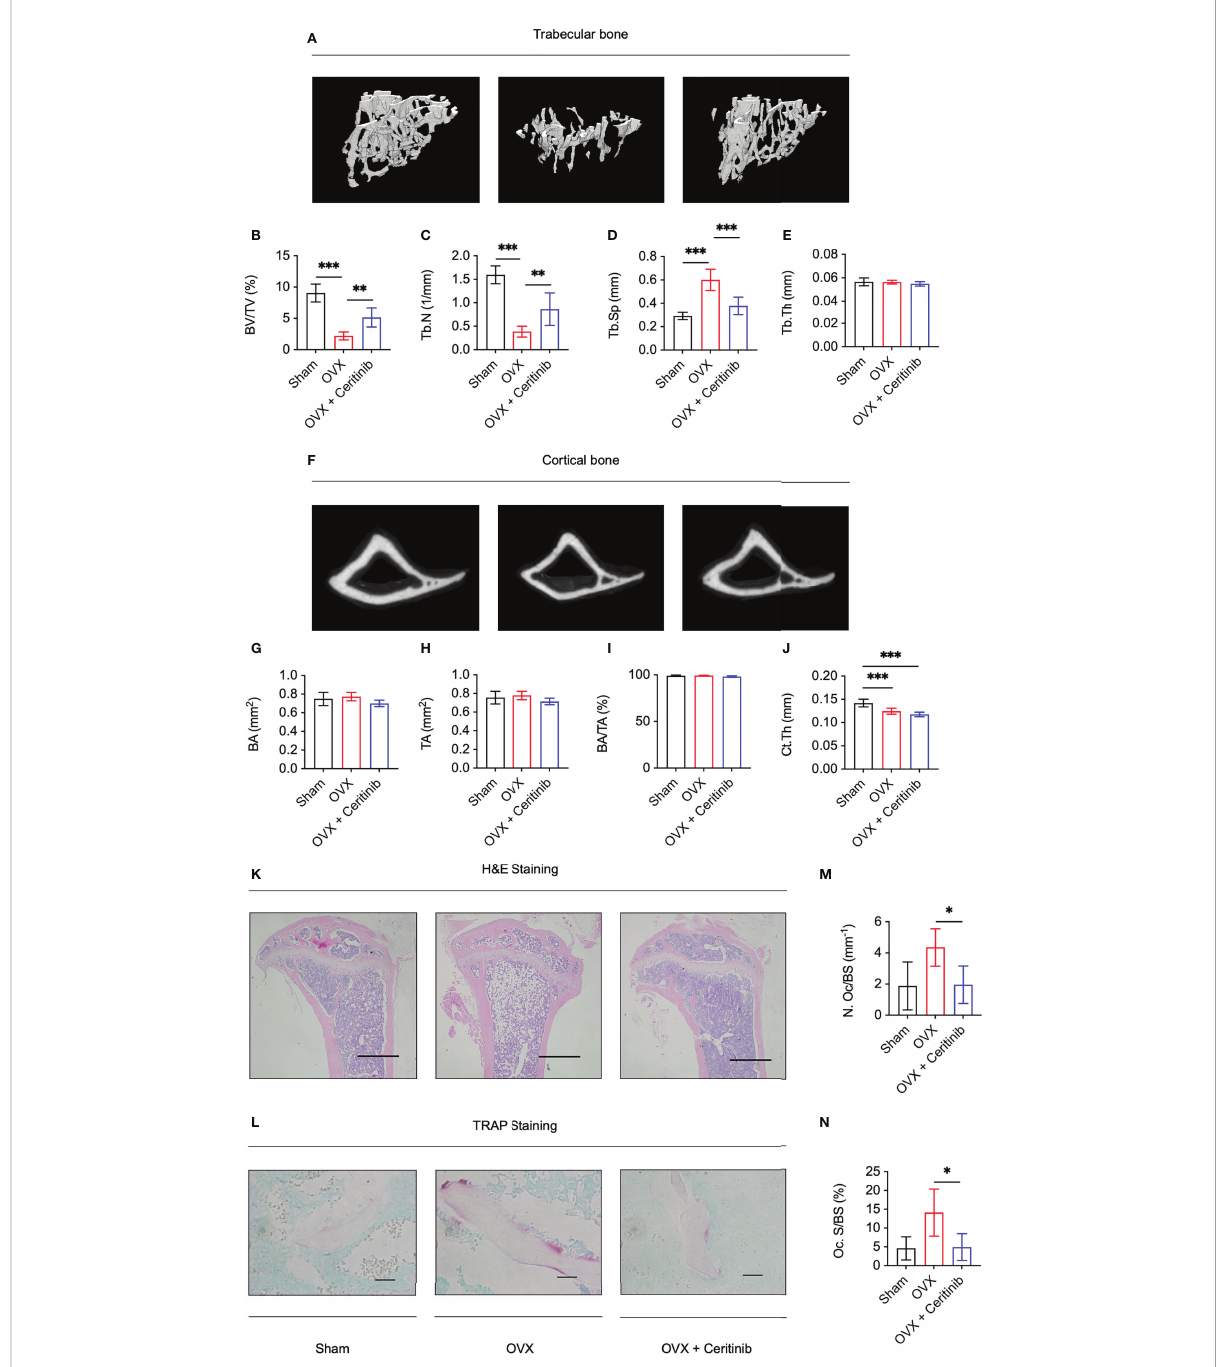
FIGURE 4 Ceritinib rescued osteoporosis by inhibiting osteoclasts in vivo . (A) Representative 3D micro-CT images of trabecular bone of the Sham, OVX, and OVX plus ceritinib groups. Micro-CT trabecular results suggest higher BV/TV (B) and Tb.N (C) , lower Tb.Sp (D) , and non-signi fi cant Tb.Th (E) in the OVX plus ceritinib group. (F) Representative 3D micro-CT images of cortical bone of the Sham, OVX, and OVX plus ceritinib groups. Micro-CT cortical results suggest no signi fi cant changes of BA (G) , TA (H) , BA/TA (I) and Ct.Th (J) in the OVX plus ceritinib group. (K) Representative images of H&E staining (Scale bar = 100 µm). (L) Representative images of TRAP staining (Scale bar = 2 µm). TRAP staining results demonstrate that ceritinib reduced the number (M) and decreased the surface of osteoclasts (N) per bone surface of trabecular bone compared to those in the OVX